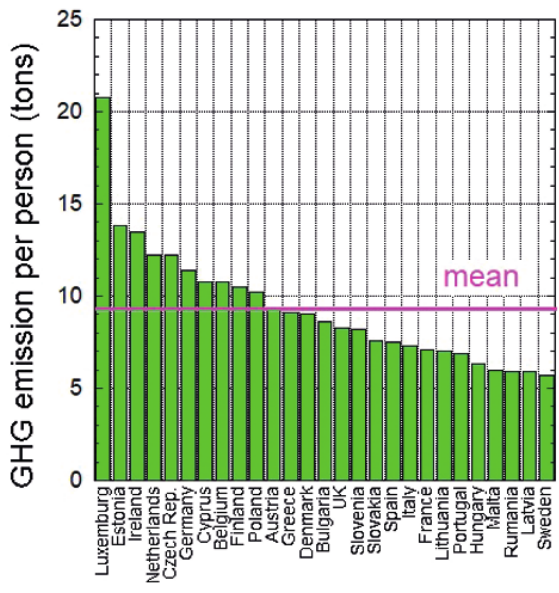
Fig. 6. – Per capita GHG emission for the different EU